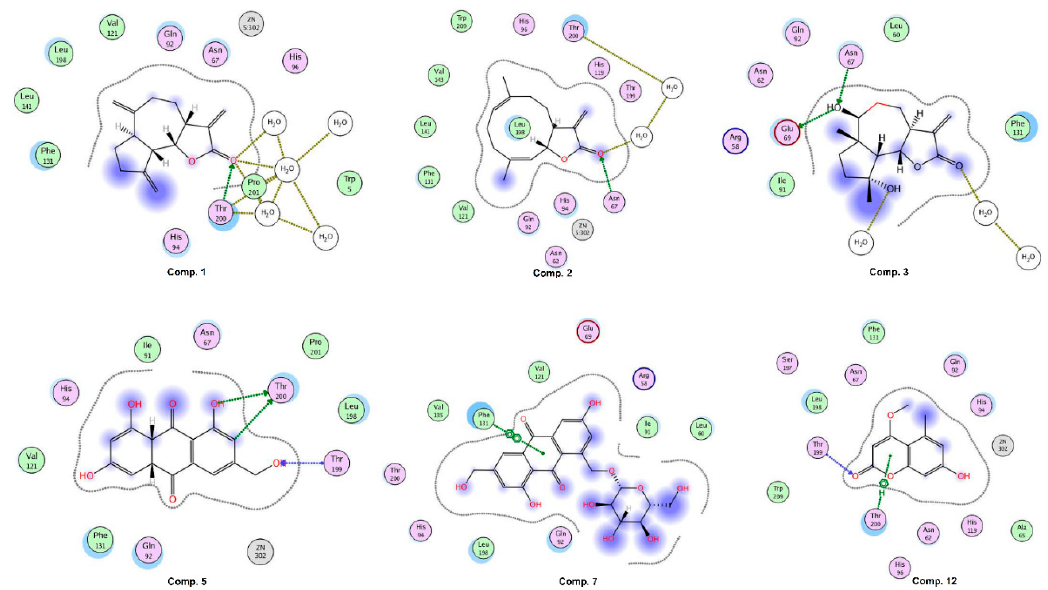
Figure 7. The binding interactions of compounds 1 – 3 , 5 , 7 , and 12 at the active site of human carbonic anhydrase II. Side chain donors / acceptors are depicted in green arrows, backbone donors / acceptors are shown in blue arrows, solvent contact is presented in yellow dotted